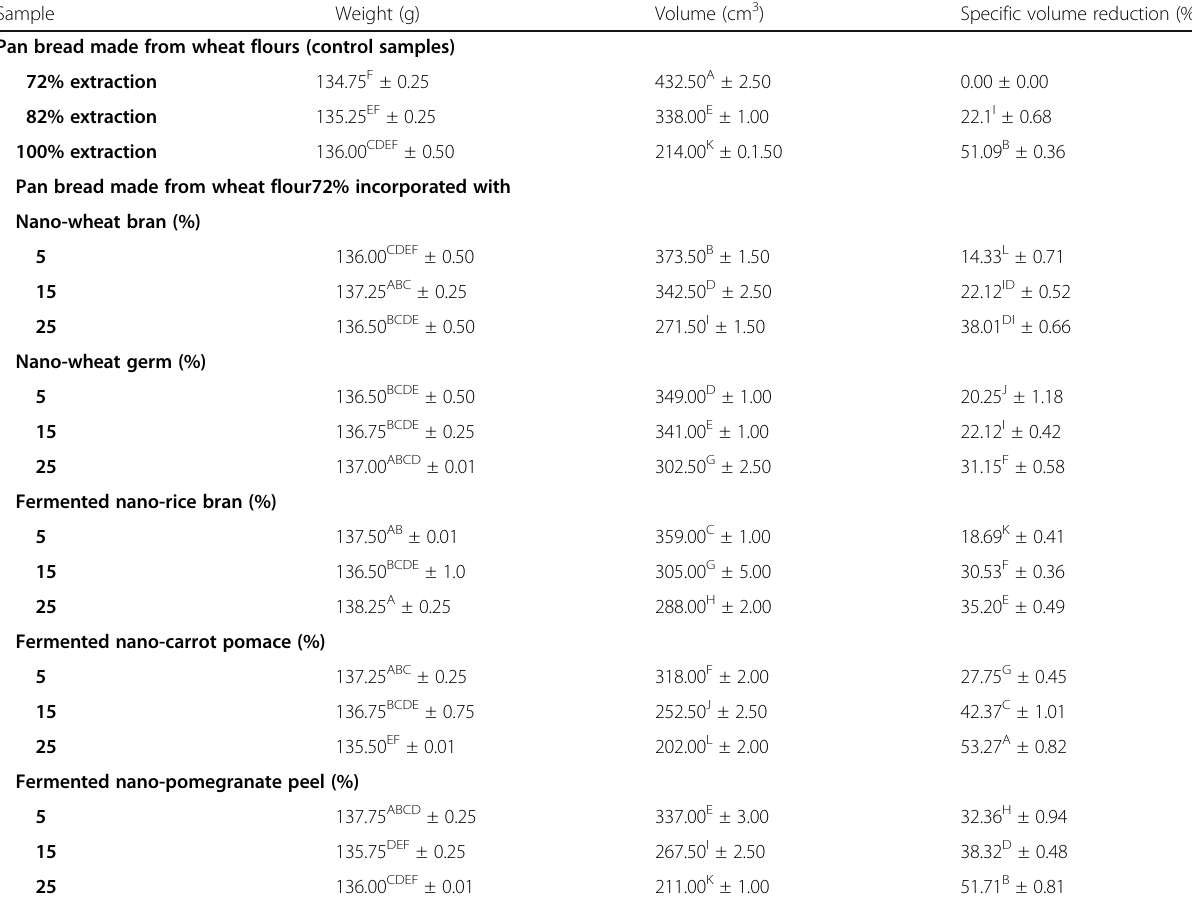
Table 1 Baking quality of pan bread as affected by addition of nano and fermented nano materials Sample Weight (g) Volume (cm 3 ) Pan bread made from wheat flours (control samples) 72%